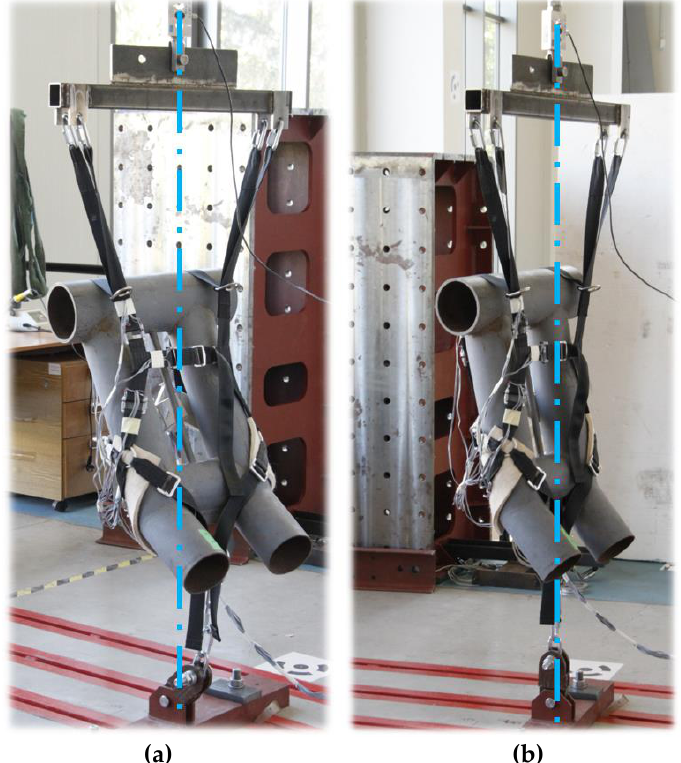
Figure 10. Rotation of the dummy during the first stage of test case one: ( a ) Unloaded, and ( b ) loaded.